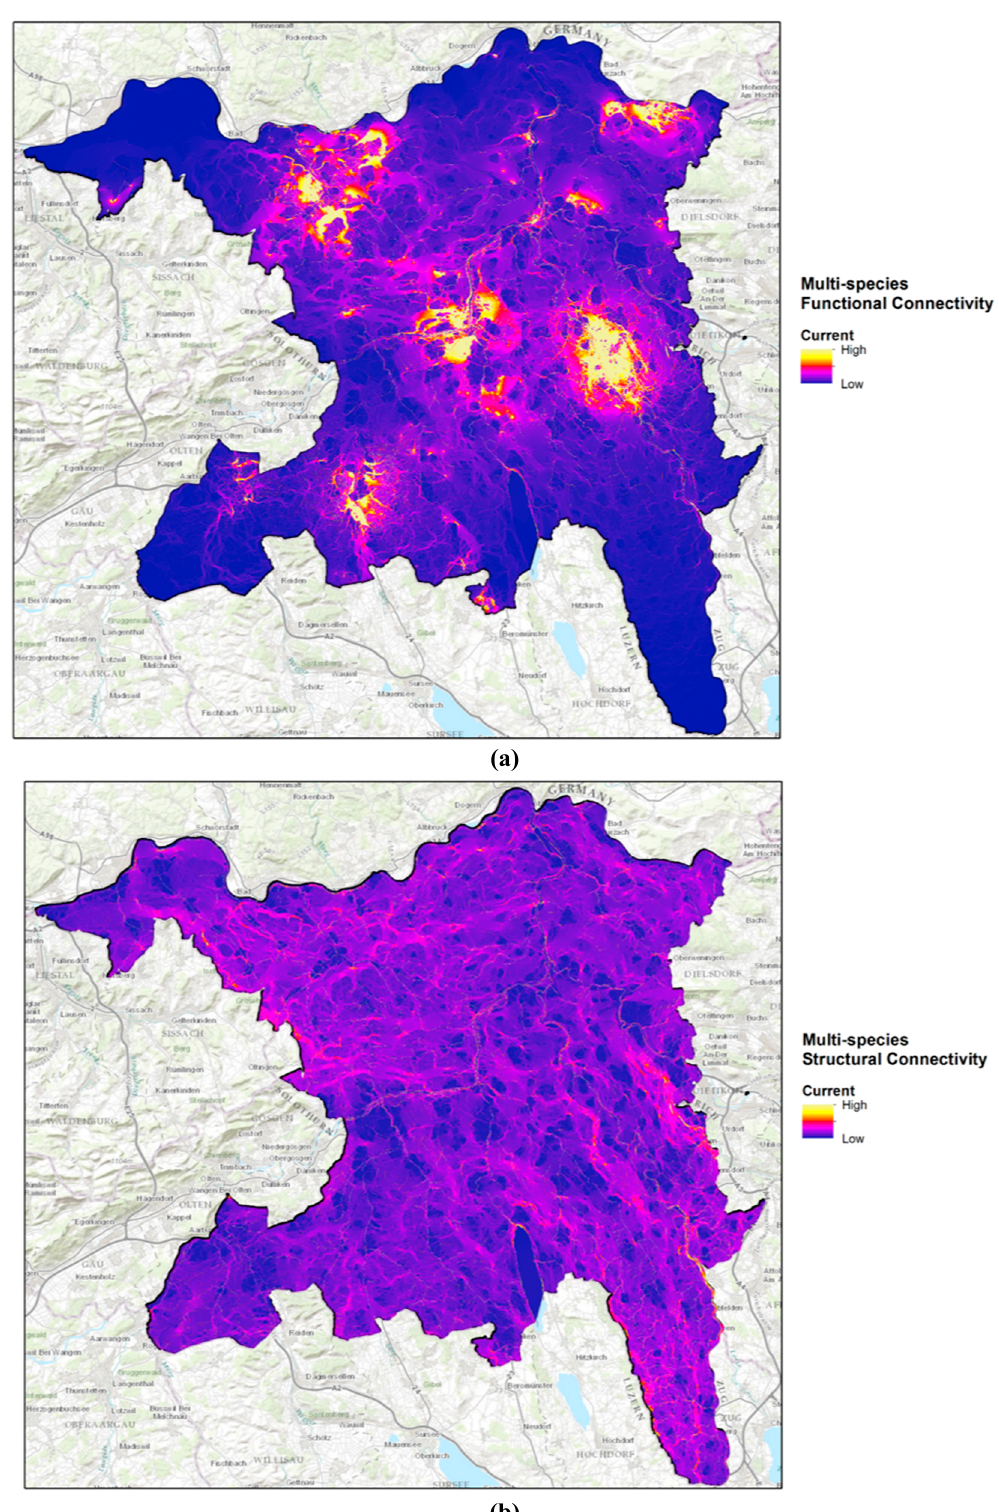
Figure 3. ( a ) multispecies functional and ( b ) structural connectivity maps under the exponential resistance scenario. The discrete color scale, from dark blue (0) to yellow (5), indicates the number of species for which each cell has a high connectivity current value.